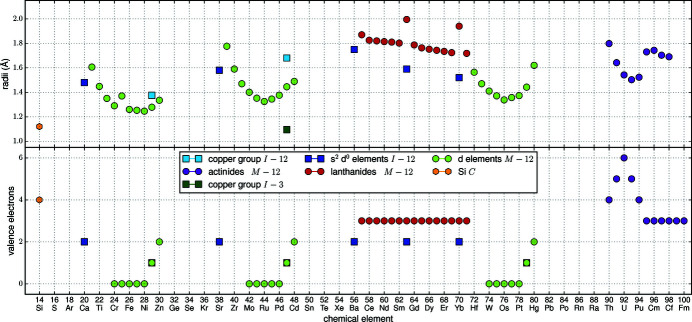
Valence electrons and radii for the chemical elements up to atomic number 100. Determination of the valence electrons based on electronic configurations from Holleman & Wiberg (2007 ▸) and considerations from §3.6. Atomic radii also from Holleman & Wiberg (2007 ▸). The groups of elements that are relevant during this work are highlighted with different colors and shapes.